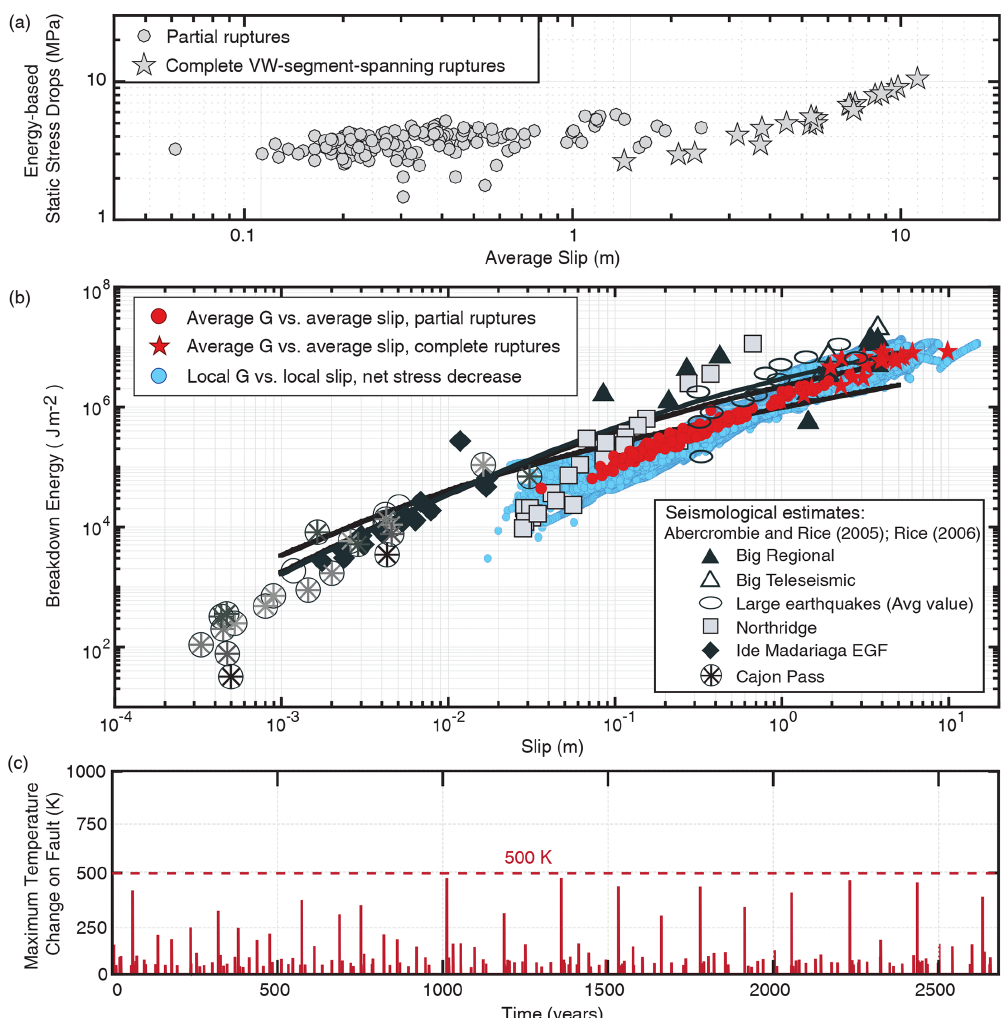
Figure 4. (a) The simulations result in a sequence of mostly crack-like ruptures that, despite including dynamic weakening due to thermal pressurization of pore fluids, are capable of reproducing nearly magnitude-invariant average static stress drops, with values between 1 and 10MPa. (b) These crack-like ruptures display the overall increasing trend in the average breakdown energy with average slip, as inferred for natural earthquakes (Abercrombie and Rice, 2005; Rice, 2006). (c) The simulated fault maintains reasonable temperatures and avoids melting, due to a relatively low interseismic effective normal stress of 25MPa (and, hence, chronic fluid overpressurization) and sufficiently efficient enhanced weakening due to thermal pressurization of pore